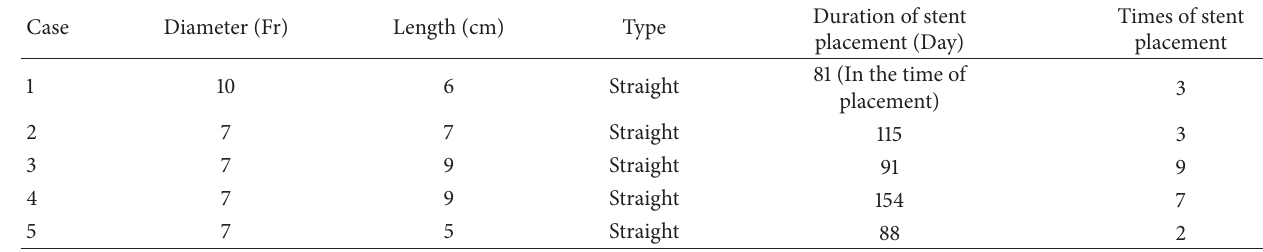
Table 4: Stents characteristics of migrated cases.